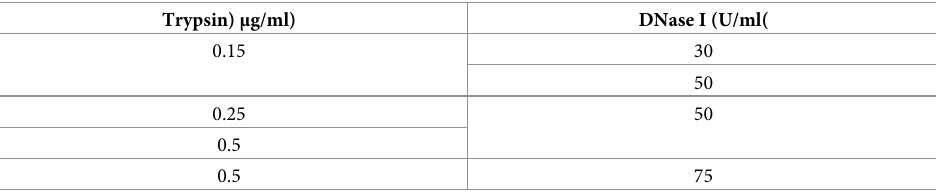
Table 2. Enzyme concentration in the